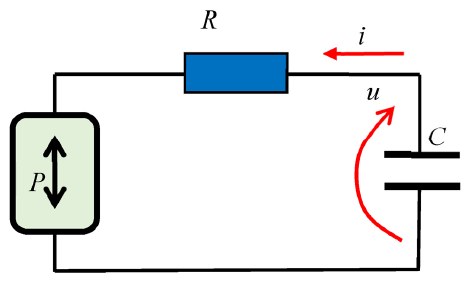
Figure 1. Discharging of a SC at constant power P .